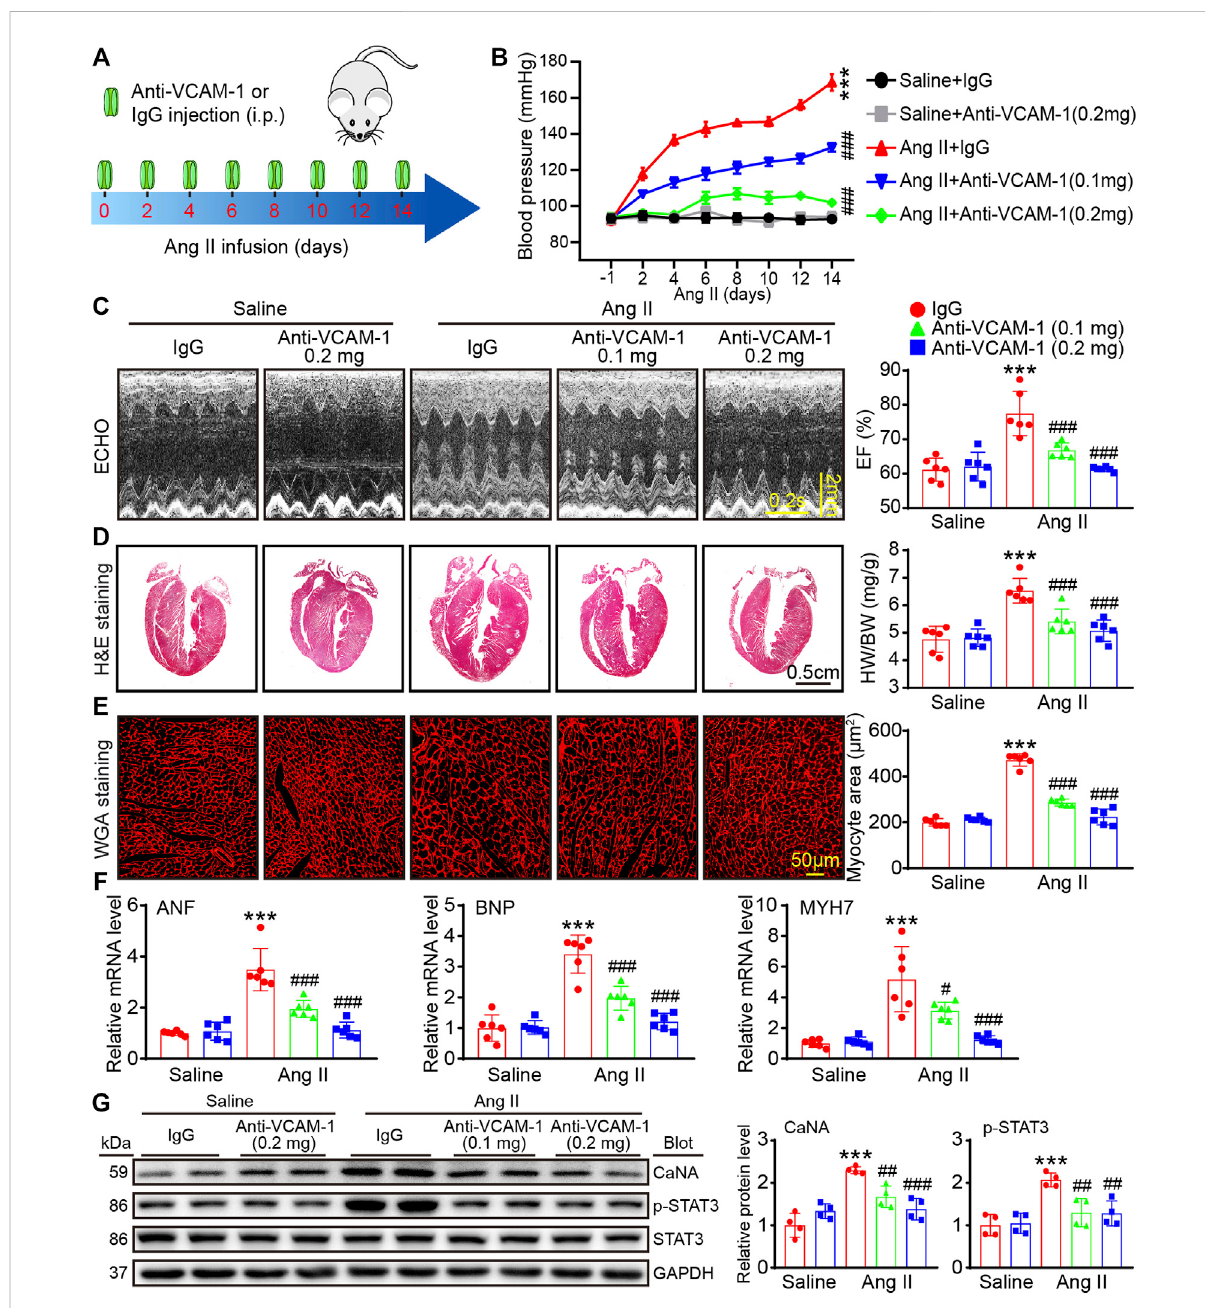
FIGURE 2 Inhibition of VCAM-1 attenuates Ang II-induced hypertension, cardiac hypertrophy and cardiac dysfunction. (A) WT mice were infused with saline or Ang II (1,000 ng/kg/min) for 14 days and cotreated with a VCAM-1 neutralizing antibody at a dose of 0.1 and 0.2 mg/mouse or IgG control every2days (B) Systolicbloodpressure (SBP)ineachgroup( n =6) (C) Echocardiographic analysis(left)and quanti fi cationoftheejectionfraction(EF %) (right, n = 6) (D) H&E staining of heart sections (left). Scale bar: 0.5 cm. The ratio of heart weight to body weight (HW/BW) (right, n = 6) (E) WGA staining of heart sections (left). Scale bar: 50 μ m. Analysis of the cross-sectional area of myocytes (right, n = 6) (F) qPCR analysis of ANF, BNP and MYH7 levels in the heart ( n = 6) (G) Immunoblot analysis of cardiac calcineurin A (CaNA) and p-STAT3 (left) and analysis of the level of these proteins (right, n = 4). The data are expressed as the M ± SD, and n represents the number of animals. *** p < 0.001 vs saline + IgG group. # p < 0.05, ## p < 0.01 and ### p < 0.001 vs Ang II + IgG